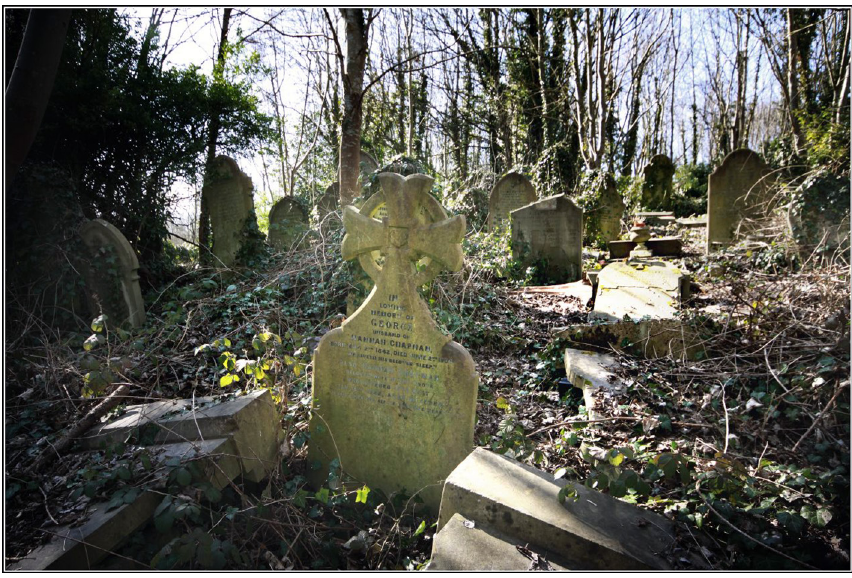
Figure 1. Victorian Arnos Vale cemetery, Bristol, England. Photo: B. Salter (Wikimedia